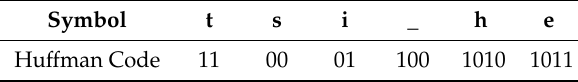
Table 2. Huffman codes of letters in ‘this_is_test’ text.